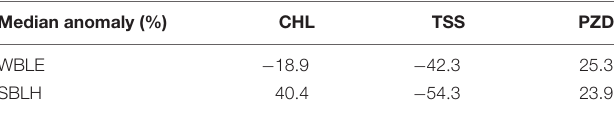
explain this observation more than the changes in human